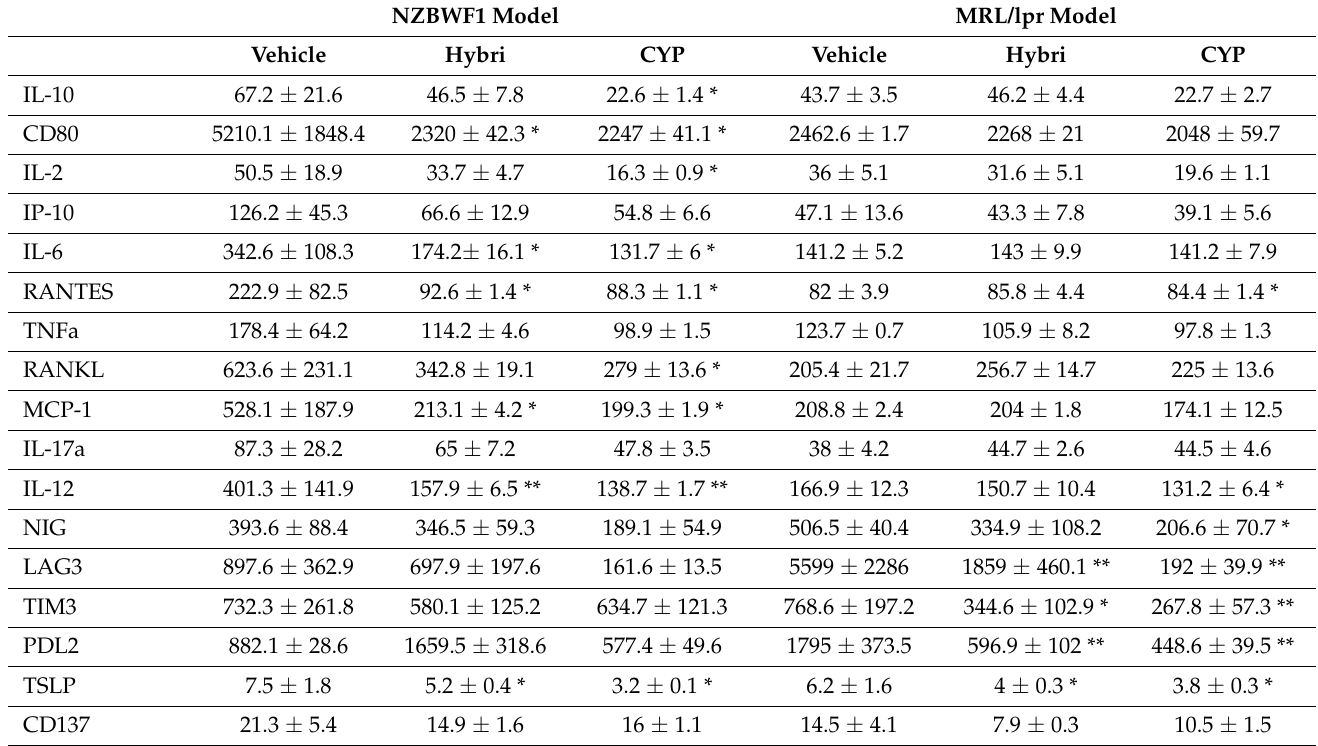
Table 2. Serum cytokine levels at the end of the experiment for all treatments: 36 weeks of age for the NZBWF1 model and 22 weeks of age for the MRL/lpr model. Values are expressed in pg/mL. Data are expressed as mean values ± S.E.M. * p < 0.05 versus vehicle; ** p < 0.01 versus